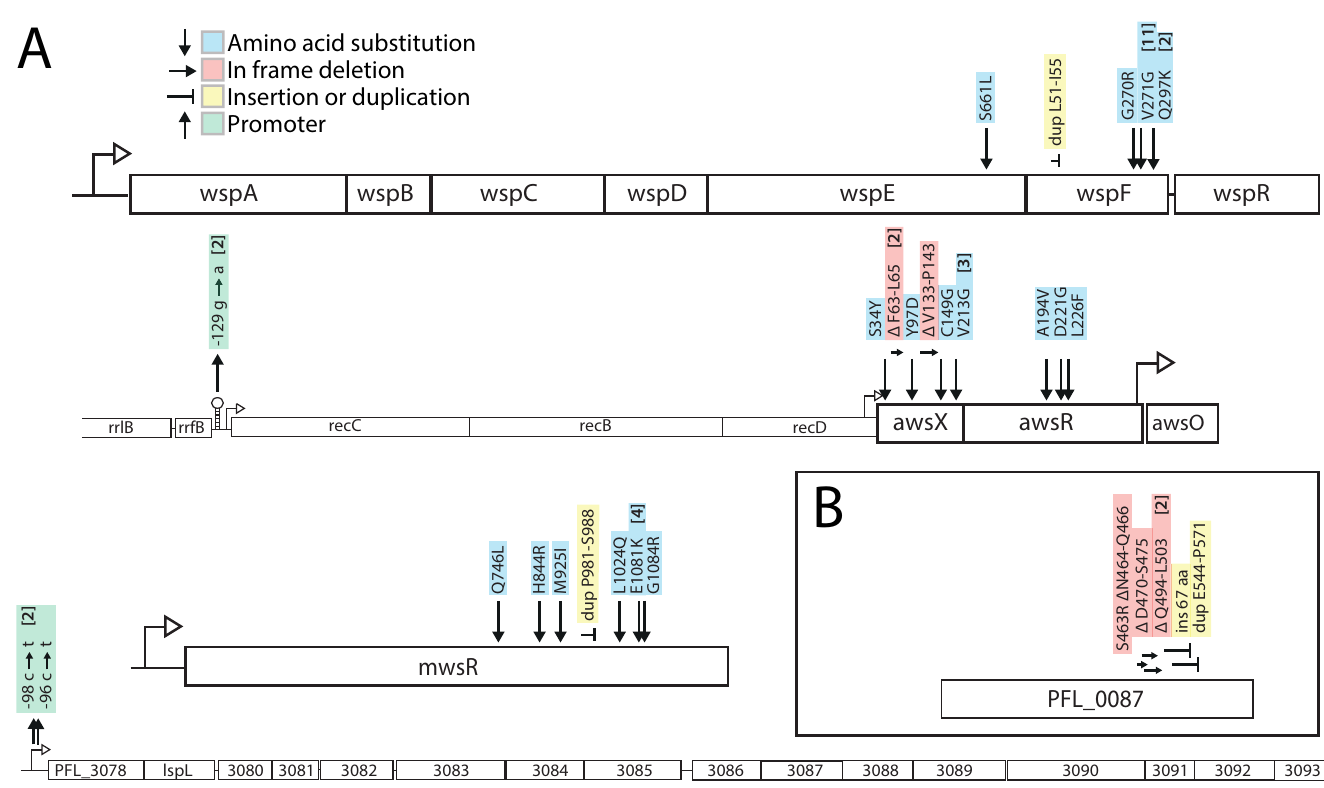
Fig 3. ( A ) Forty-three independent mutants of wild type Pseudomonas protegens Pf-5 were isolated after experimental evolution based on their divergent colony morphology and mutations were identified in four operons. Numbers in brackets are the number of independent mutants found. Details are available in S2 Table. ( B ) Experimental evolution with a Δ wsp Δ aws Δ mws triple deletion mutant resulted in WS types with mutations in the DGC PFL_0087/DgcH. found in WspA despite a predicted high rate (Fig 1E). The majority (16 out of 22) of the mutated sites or regions was predicted (Prediction 7) for WspF, WspE, AwsX, AwsR and MwsR (Fig 2), but in most cases they were not identical to those in SBW25 (S2 Table). A fur- ther analysis of the likely functional effects of mutations and how they change reaction rates in the mathematical model of the genotype-to-phenotype map is available in the S1 Text and S2 Table. Identical WspF V271G missense mutations accounted for 11 out of 15 mutations in this protein, which could indicate a putative mutational hot spot site or a greatly increased fitness relative to other WS mutants. The previously described mutational hot spots sites in SBW25 in the awsX , awsR and mwsR genes [26] appeared absent, demonstrating how mutation rate dif- ferences can skew evolutionary outcomes even for closely related species with similar geno- type-to-phenotype maps. Mutations in WspA were predicted to be one of the major mutational routes to WS based on the mathematical model (Prediction 6, Fig 1E, [26]), but no mutations were found either in this study or in SBW25 [23]. However, when the mutational spectrum of WS mutants in SBW25 was determined in the absence of selection for growth at the air-liquid interface, WspA mutants occurred at rates similar to those of WspE and WspF, as predicted by the model, and their low frequency after experimental evolution could be explained by their lower fitness [26]. To test if a WspA mutation could cause a WS phenotype in P . protegens and measure its fitness, a common deletion mutation found in SBW25 (WspA